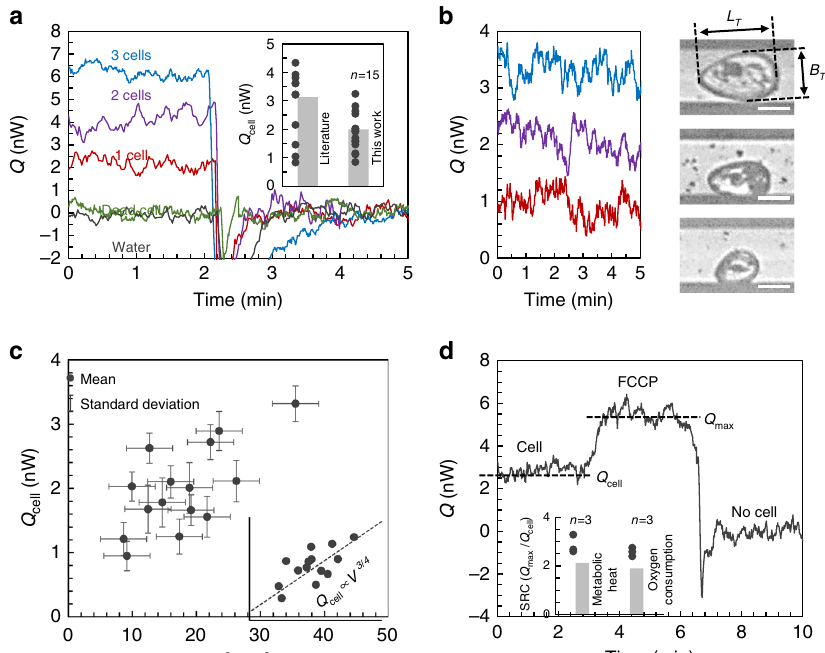
Fig. 4 Metabolic rate measurement results. a Basal metabolic rate ( Q cell ) of one (red line), two (purple line), three (blue line), and dead cells (green line) as well as the heat signal from water injection without cells (black line). A clear increase of the heat signal was observed with increasing number of cells, whereas no heat signal was detected for the dead cell or water injection without cells. The inset graph compares the Tetrahymena metabolic rate from the literature (3.1 ± 1.4 nW, where the ±error represents standard deviation) 29 – 31 and this work (2.0 ± 0.7 nW)), where n = 15 independent single cell measurements were performed. b Single-cell metabolic rate for various sizes of Tetrahymena . The large cell (35 × 10 3 μ m 3 , blue line), medium cell (16 × 10 3 μ m 3 , purple line), and small cell (9 × 10 3 μ m 3 , red line) exhibited metabolic rates of 3.3, 2.1, and 0.9 nW, respectively. The scale bars in the images all represent 30 μ m. n = 15 independent single cell images were taken, corresponding to the 15 calorimetry of single cells. c Summary of single-cell metabolic rate as a function of cell size ( V ). Black dots represent individual mean value of Q cell collected for 5 min from n = 15 independent single cell measurements with different cells. The x -axis error bars represent standard deviation of heat signals measured every 0.5 s for 5 min ( n = 600) while the y -axis error bars are based on possible standard deviation errors of cell size measurement (see “ Methods ” section for details). The inset presents the results on the logarithmic scale. The dotted line in the inset represents a three-quarter power allometric scaling relationship ( Q cell ∝ V 3/4 ). d Representative metabolic heat measurement result with FCCP stimulation. The cell metabolic rate was increased upon dosing FCCP to the cell at 3 min among n = 3 independent experiments with different cells. The inset shows the SRC (ratio of maximum metabolic rate, Q max , to Q cell ) measured by our single-cell calorimeter and a conventional oxygen electrode chamber on a bulk volume of Tetrahymena . Source data for 4 a – d are provided as a Source Data fi